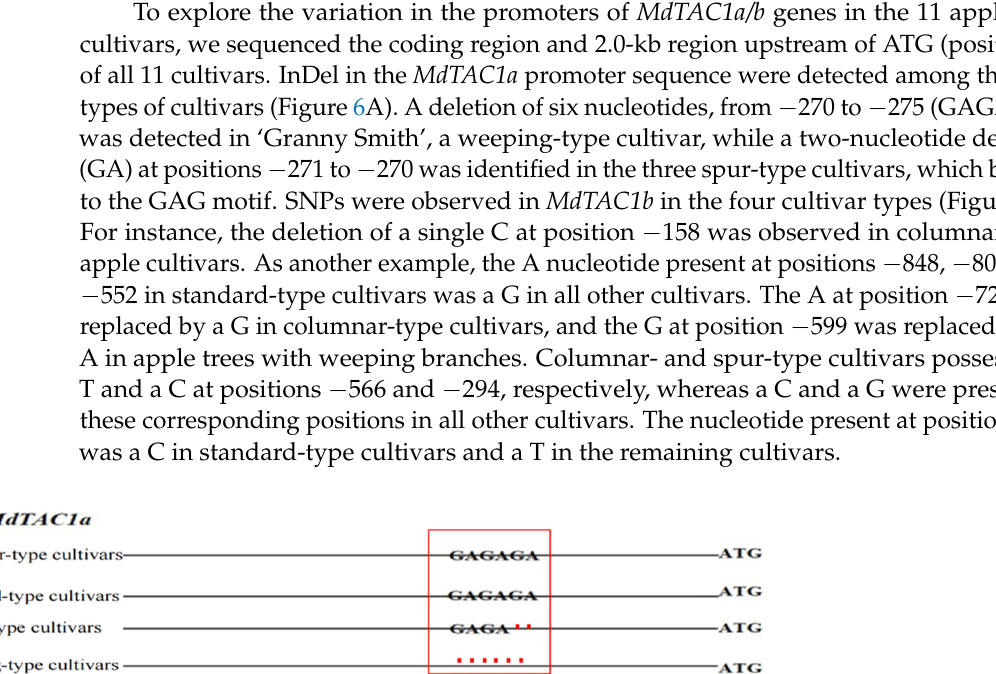
Figure 7. Genotyping of TAC1a in apple cultivars by an InDel markerThe upper imageshowedthe branch angle size of 21 apple cultivars, and the lower electrophoresis pattern showed the separation